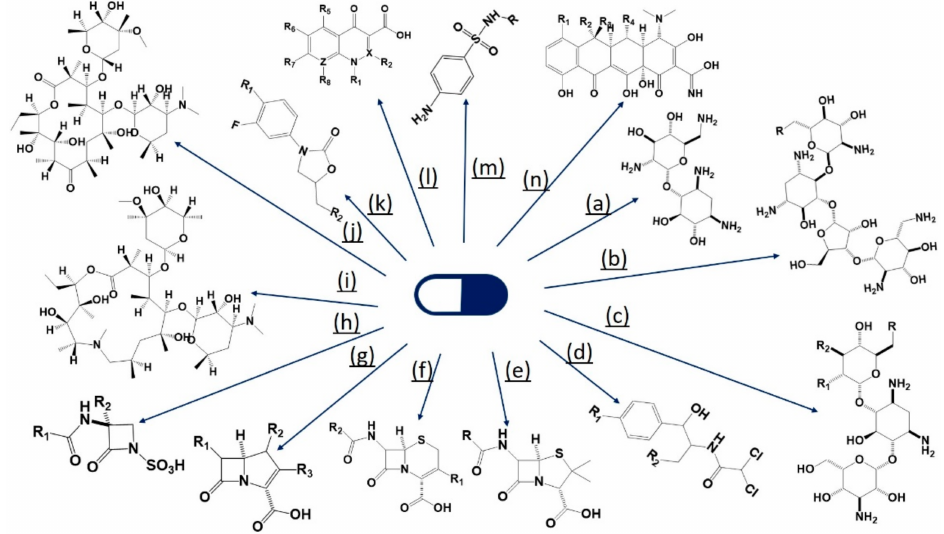
Figure 1. Chemical structures of the main classes of antibiotics: ( a ) monosubstituted 2-DOS AGs; ( b ) 4,5- and ( c ) 4,6-disubstituted 2-DOS AGs; ( d ) amphenicols; ( e ) penicillins; ( f ) cephalosporins; ( g ) carbapenems; ( h ) monobactams; ( i ) AZY ( j ) ERY; ( k ) oxazolidones; ( l ) quinolones [21]; ( m ) sulfonamides; ( n )